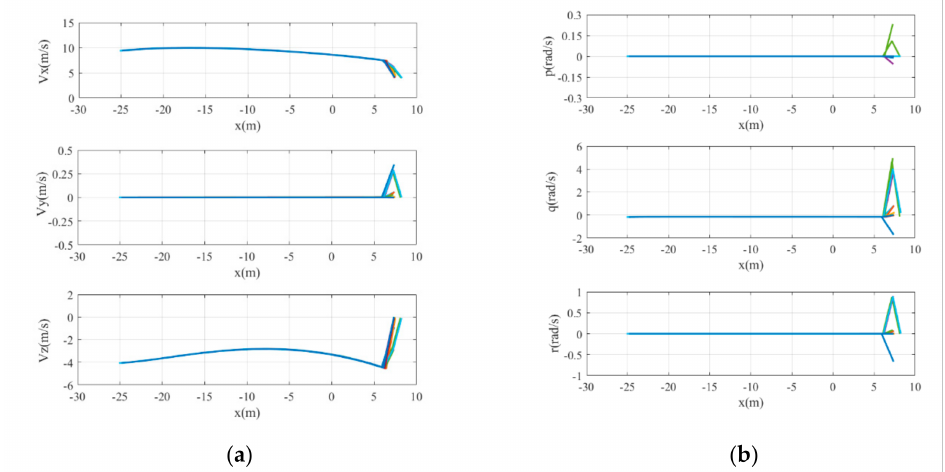
Figure 11. The UAV states under case 1. ( a ) global linear velocities. ( b ) body rates.